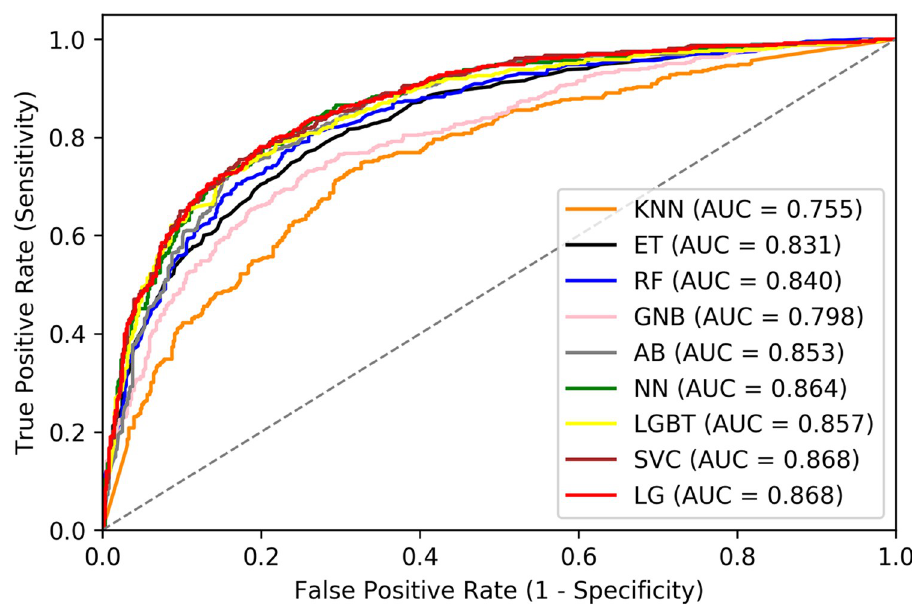
Fig 2. ROC curve analysis of nine different machine learning algorithms using the validation cohort in the IWPC cohort. AB: AdaBoost, ET: Extremely Randomized Tree, GNB: Gaussian Na ï ve Bayes, KNN: K Nearest Neighbors, RF: Random Forests, LGBT: Light Gradient Boosting Tree, LG: Logistic Regression, NN: Neural Network, SVC: Support Vector Machine. https://doi.org/10.1371/journal.pone.0267966.g002 the warfarin sensitive group, primary outcome events occurred in 158 patients (4.14%), com- pared with 117 of 3833 (3.05%) in the warfarin normal group. In the multivariate logistic regression analyses, after adjusting age, height, weight, gender, race, service unit, SAPS score, SOFA score, interventions, comorbidities, clinical lab tests and vital signs on admission to ICU, warfarin sensitivity was significantly associated with higher primary outcome events (OR, 1.33; 95% CI, 1.01–1.77; P = 0.045) compared to normal warfarin sensitivity. To account for confounding that could lead to the protective association between warfarin sensitivity and the primary outcome, we further performed PSM and propensity score-based inverse Table 2. AUC, accuracy and F1 score for different machine learning algorithms using 5-fold CV in the IWPC cohort.